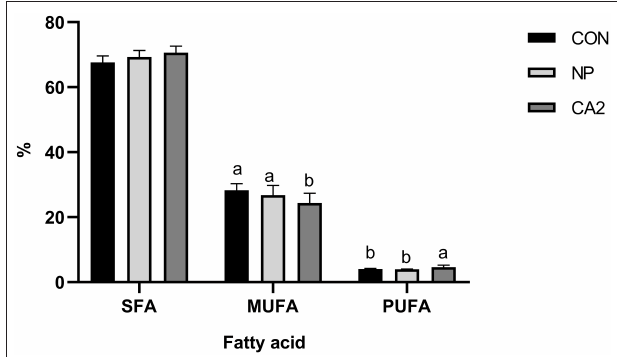
FIGURE 2 | Effects of processed whole cottonseed (WCS) on the milk fat profile. SFA, saturated fat acid; MUFA, monounsaturated fatty acid; PUFA, polyunsaturated fatty acids. CON, diet without WCS; NP, diet added with 8% unprocessed WCS; CA2, diet supplemented with 8% crush-alikali2-treated WCS. In the column diagram above, values with different small letter superscripts indicate significant difference ( P < 0.05), while with the same or no letter superscripts indicate no significant difference ( P >